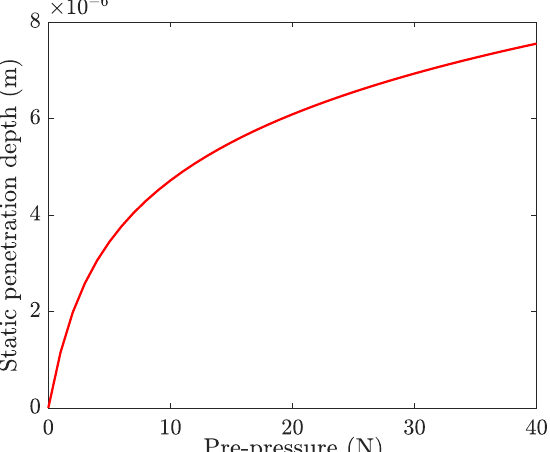
Figure 18. Variation of a nodal displacement with